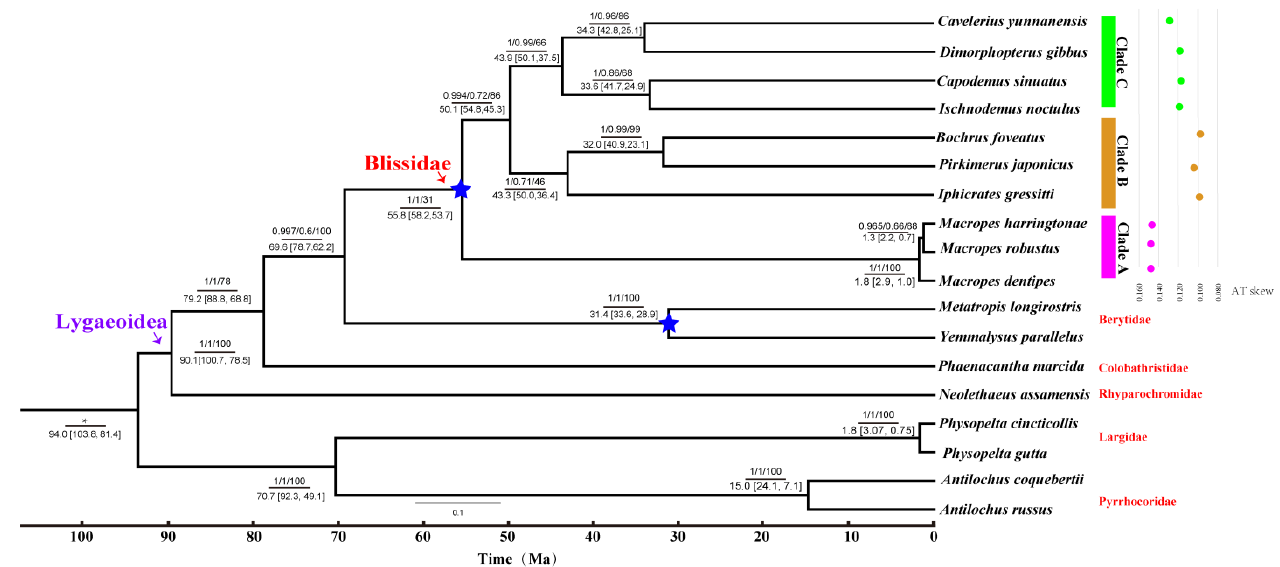
Figure 4. Phylogenetic tree and divergence time estimation inferred from PCG12RT. (Numbers in nodes: numbers above the line are posterior probability from MrBayes/posterior probability from Phylobayes-MPI/bootstrap from IQ-TREE, asterisk indicates that relevant parameters are not obtained; numbers below the line are divergence times; nodes marked with five pointed stars represent fossil marks.)